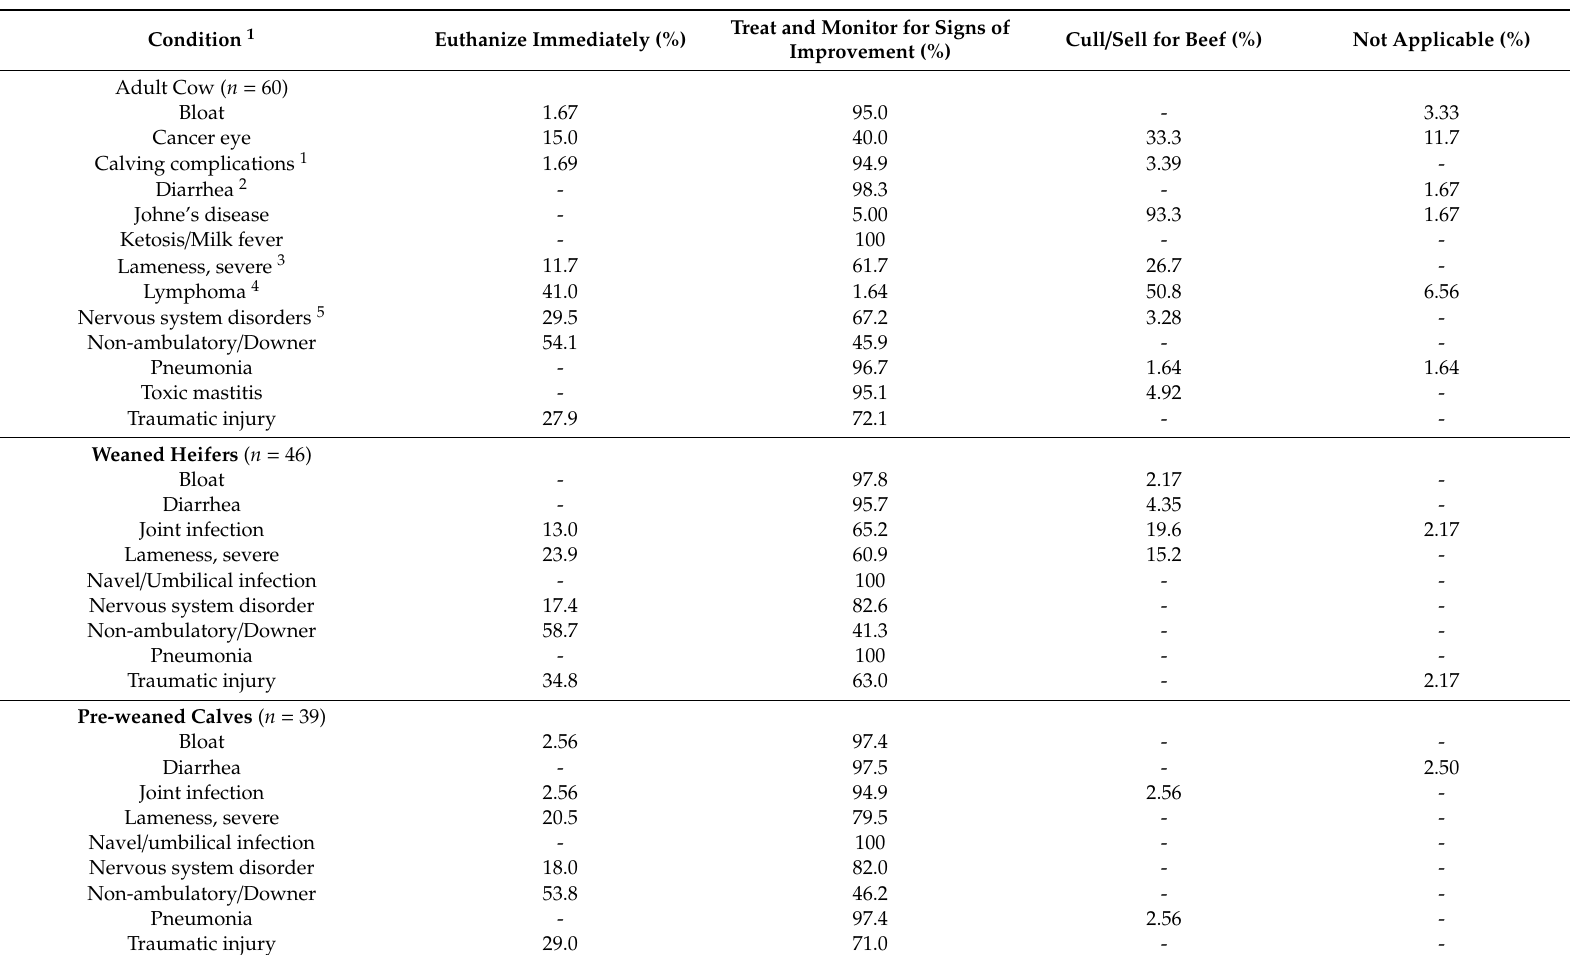
Table 2. Response percentages of surveyed dairy cattle veterinarians ( n = 48) when asked to select how they would manage the following conditions. Condition